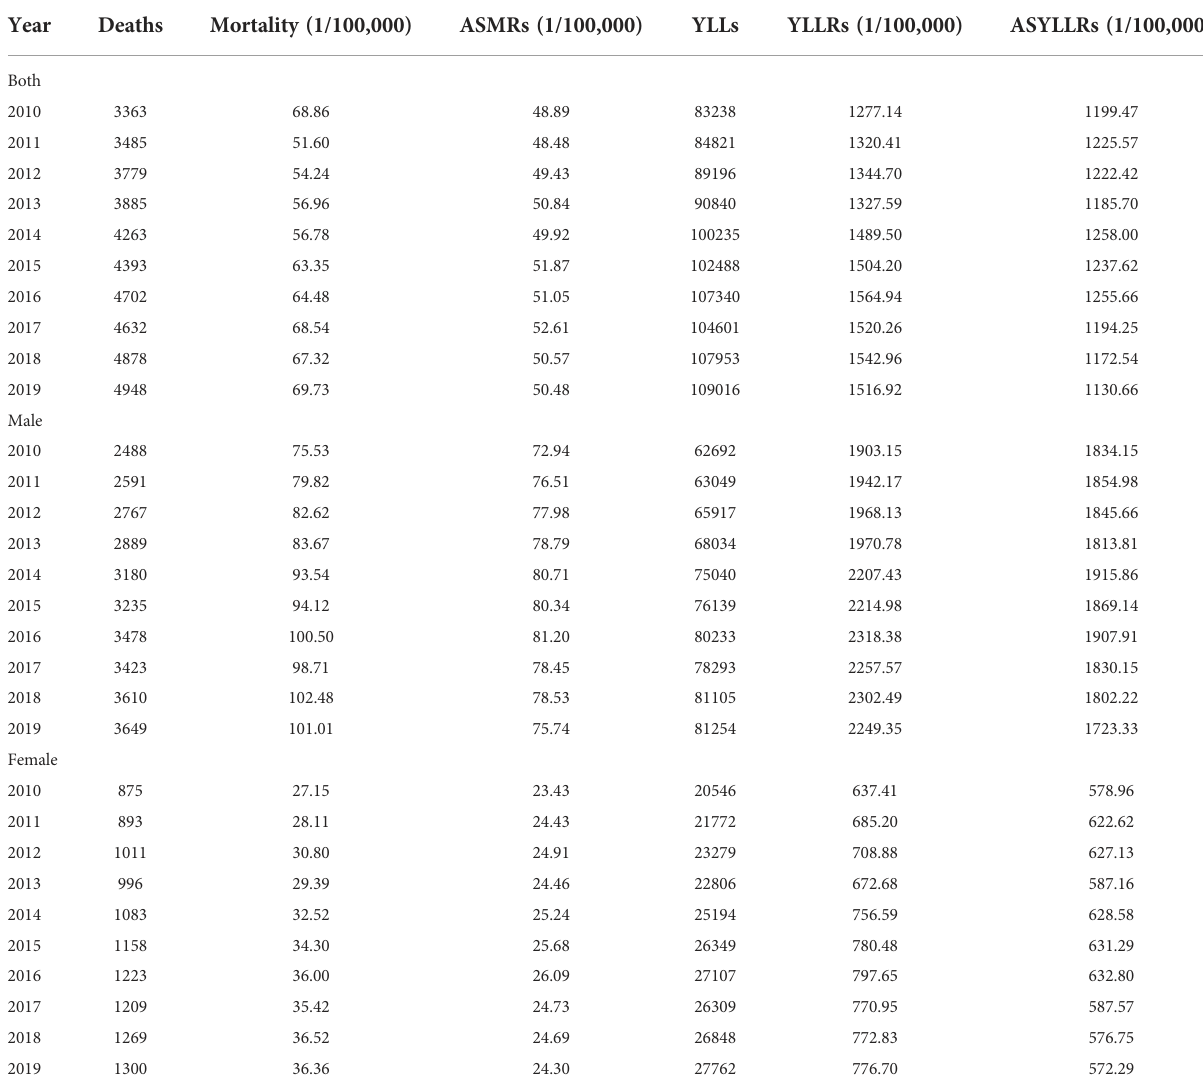
TABLE 1 Trends in the burden of lung cancer death in Wuhan,